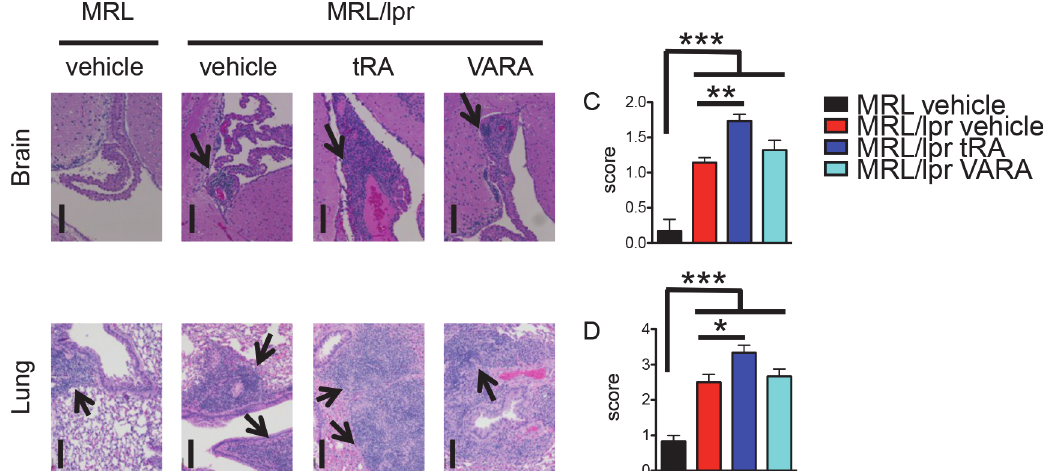
Fig 2. tRA-induced pathology in the brain and lung. Starting from 6 weeks of age, MRL and MRL/lpr mice were given, orally and daily, vehicle (canola oil), tRA (6 mg/kg BW), or VARA (6 mg retinol and 0.6 mg tRA per kg BW) till 14 weeks old when tissues were collected. n = 6 mice in each group. (A) H&E stains of the brain. Representative micrographs are shown. Bar equals 100 m. (B) H&E stains of the lung. Representative micrographs are shown. Bar equals 50 μ m. Arrows indicate areas of infiltration. (C-D) Leukocyte infiltration scores of the brain (C) and lung (D) according to H&E stains. * P < 0.05, ** P < 0.01, *** P < 0.001, one-way ANOVA. Data are shown as mean +